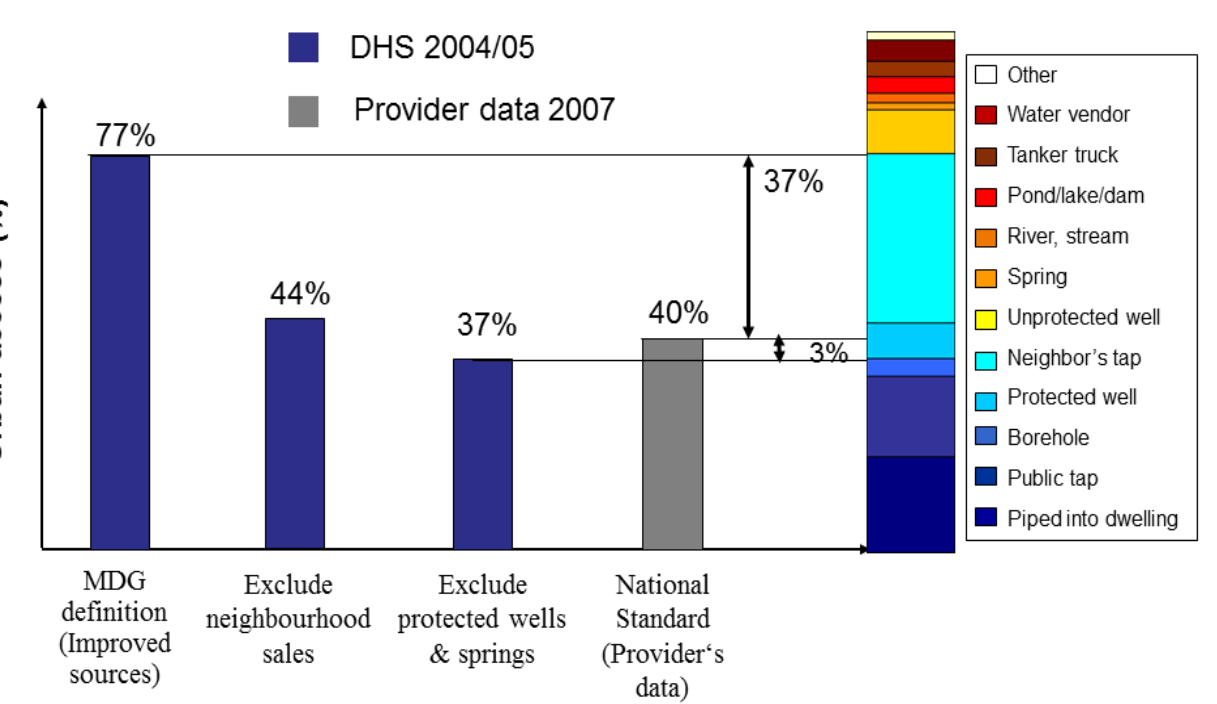
Figure 5. Comparison of line ministry reported drinking water coverage rates vs. coverage rates calculated from Household Surveys for